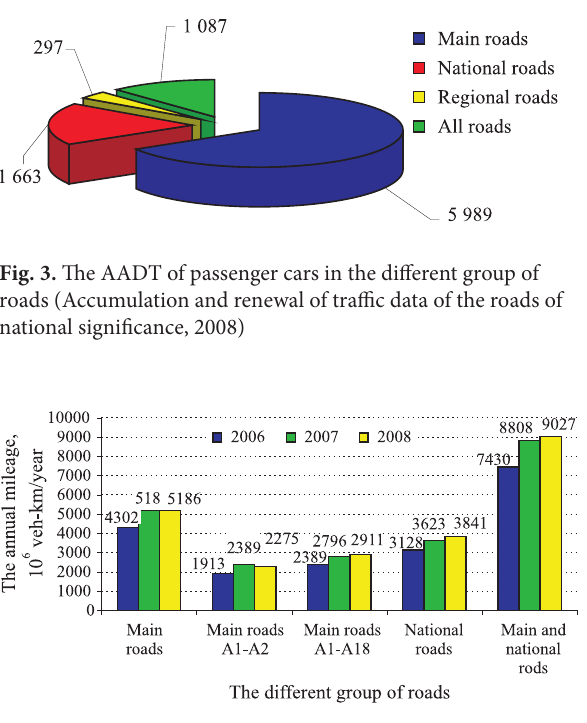
Fig. 4. Th e calculated annual mileage in the diff erent group of roads depending on traffi c volume and length of road